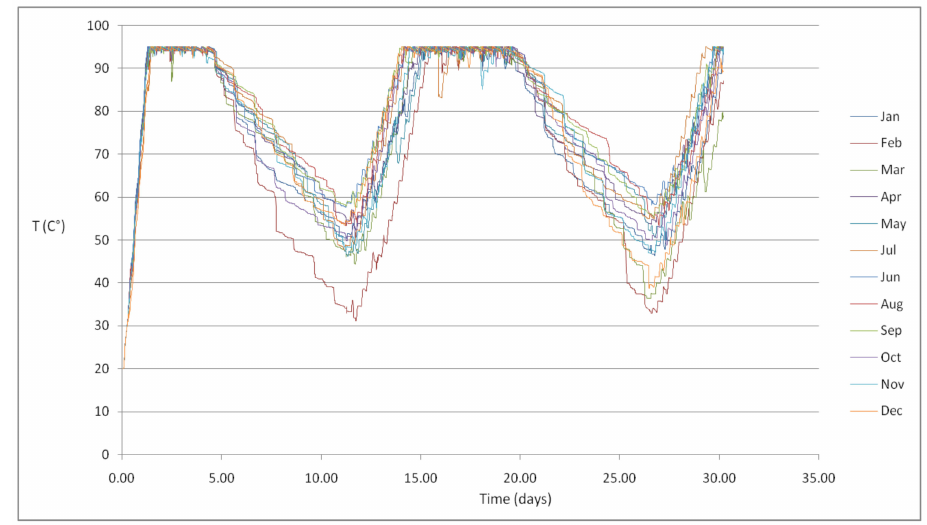
Figure 13. The temperature in the 1 m 3 HWT (Case